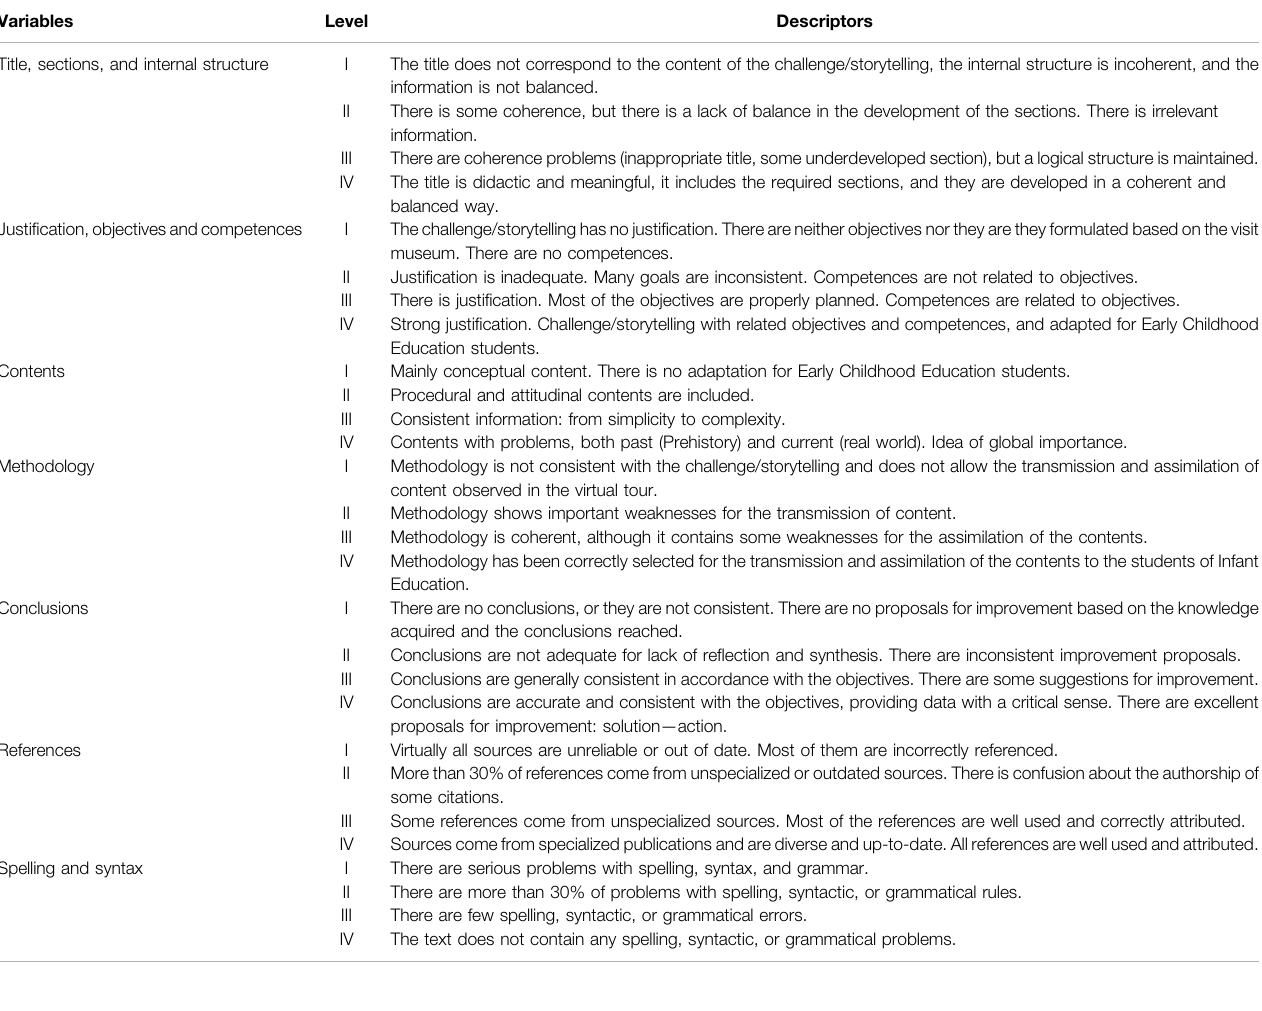
TABLE 1 | Rubric for evaluating ECPT ’ s challenge-based learning. Variables